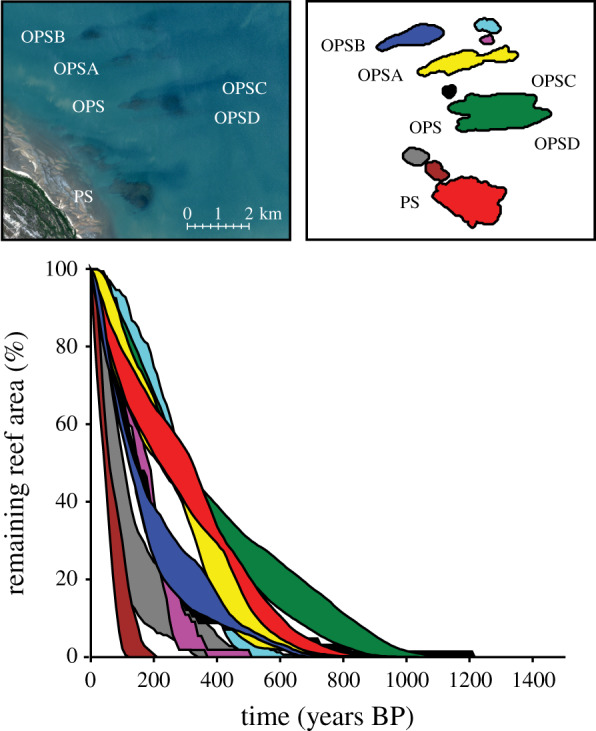
Per cent (%) of remaining reef area as reef morphology is modelled backwards from present day to reef initiation (i.e. start-up). Model simulations assume no sea-level change and constant (but depth-variable) reef accretion rates. Lines represent the min/max estimated change from a 95% confidence window using 100 bootstrap samples calculated for different seafloor extrapolations (see Material and methods). Colours indicate the reefs that form the PSRC (PS, OPS A–D). (Online version in colour.)